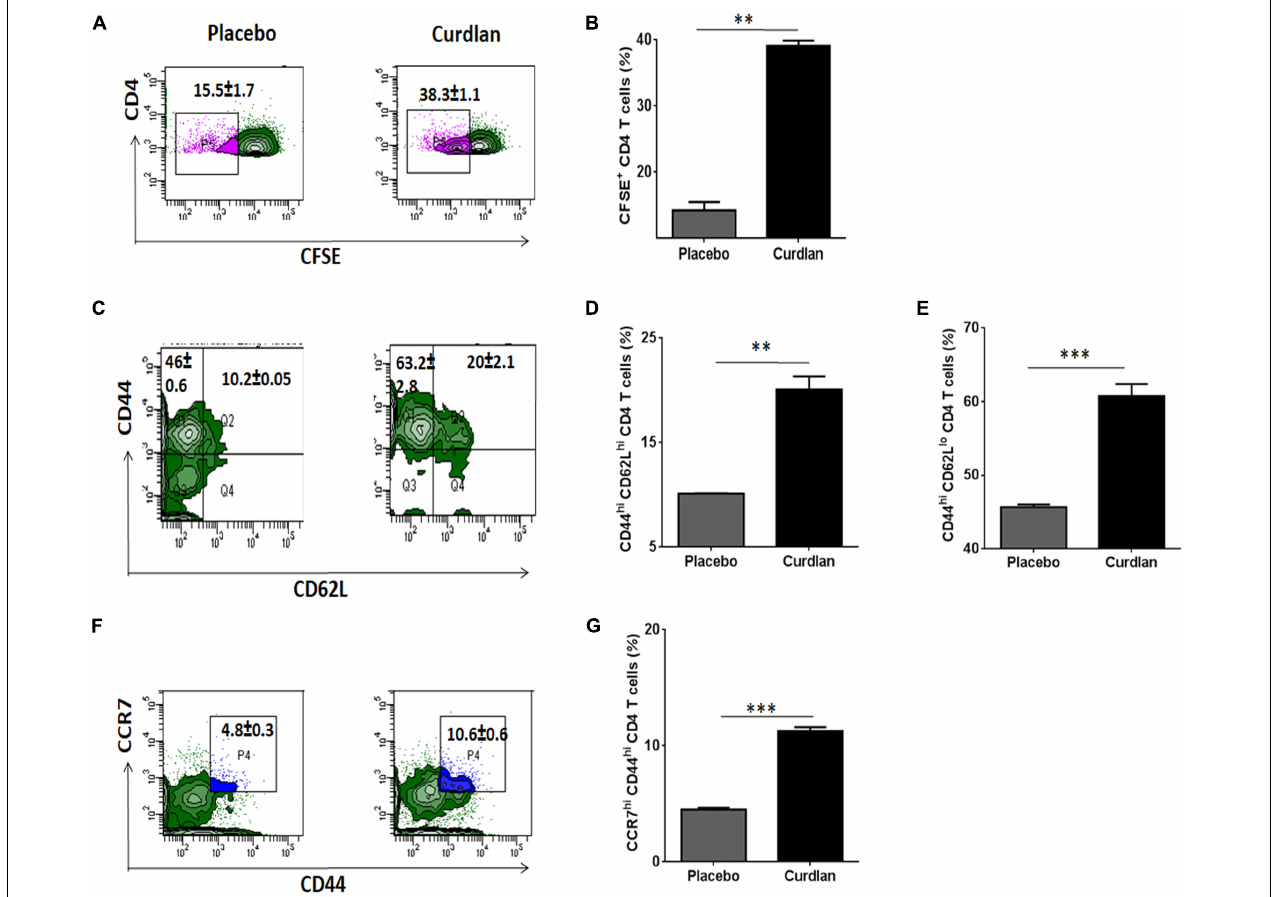
FIGURE 6 | Curdlan administration evokes T cell proliferation and generates enduring memory response in Mtb infected mice. Mtb challenged animals were immunized with curdlan as stated in legend to Figure 4 . After 7 weeks post challenge, lung cells were harvested and (A,B) CFSE (2 µ M) labeled prior to in vitro culture with PPD (25 µ g/ml) for 72 h to monitor CD4 T cell proliferation by flow cytometry. Additionally, (C–G) lung cells suspension were stained with fluorochrome tagged antibodies and their isotype controls as described in section “Materials and Methods” and examined for (C,D) Central (CD4 + /CD44 hi /CD62L hi ); (C,E) Effector memory phenotype (CD4 + /CD44 hi /CD62L low ) and (F,G) CD4 + /CD44 hi /CCR7 hi cells gated on CD4 T cells by flow cytometry analysis. Numbers in the inset of flow cytometry plot and bar graphs indicates the percentage of positive cells. The data are represented as mean ± SD and representative from two independent experiments. Each experimental group was composed of 4–5 mice. ∗∗ p ≤ 0.01, ∗∗∗ p ≤ 0.001. Placebo, Mtb infected mice administered with PBS; Curdlan, Mtb infected mice treated with